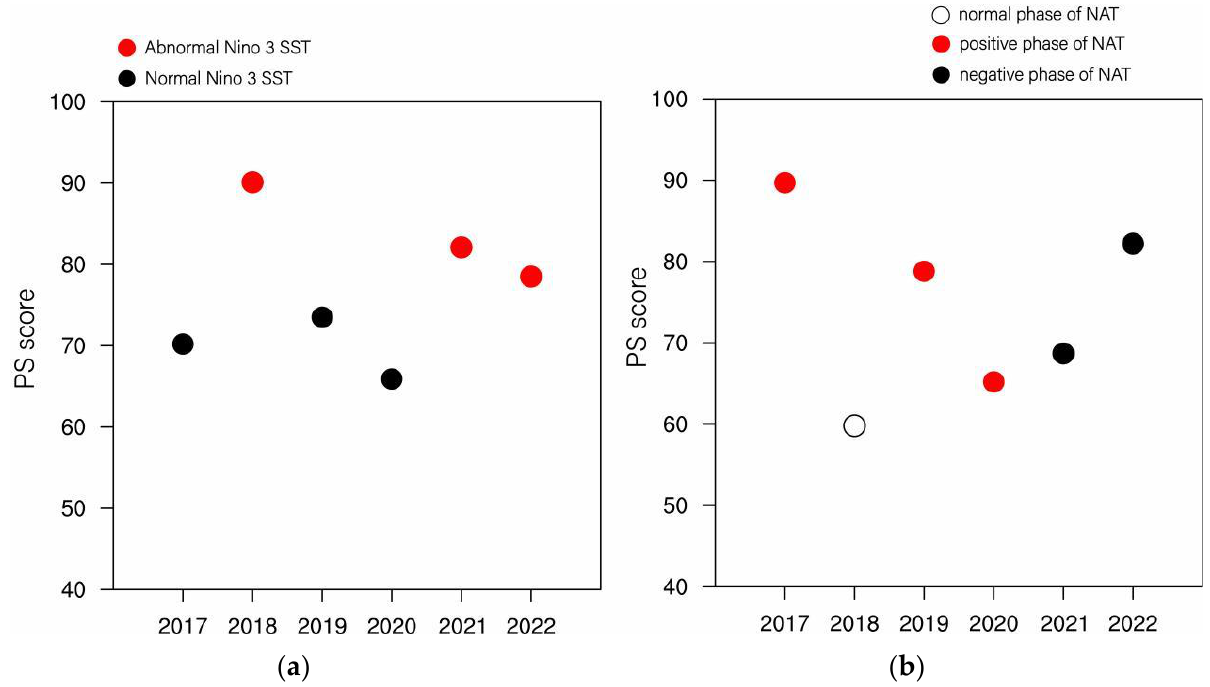
Figure 2. Flood-season precipitation forecast by ( a ) the dynamic – analogue correction method and ( b ) hybrid downscaling method. The Y-axis is the PS score.